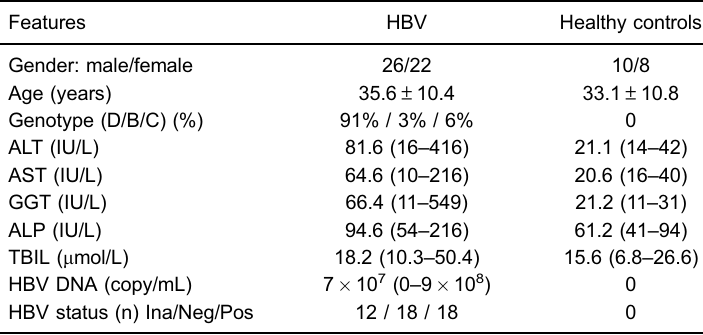
Table 1. Clinical characteristics of